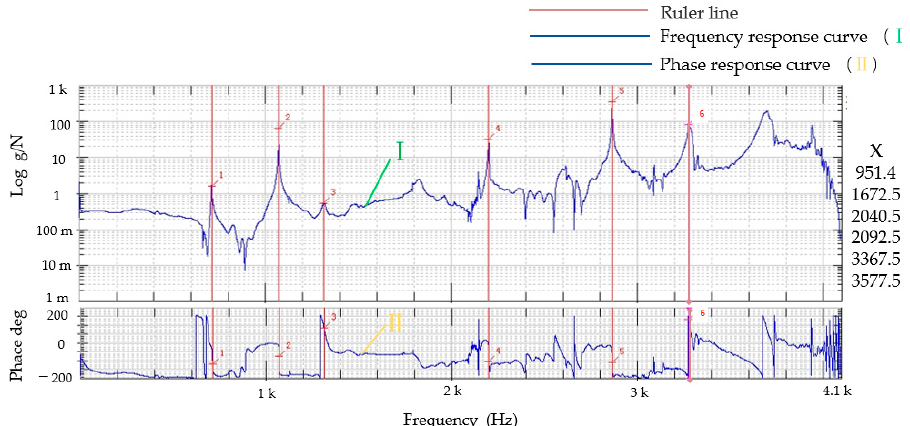
Figure 14. Diagram of the experimental dynamic performance of the micro-drive reduction mecha- nism.